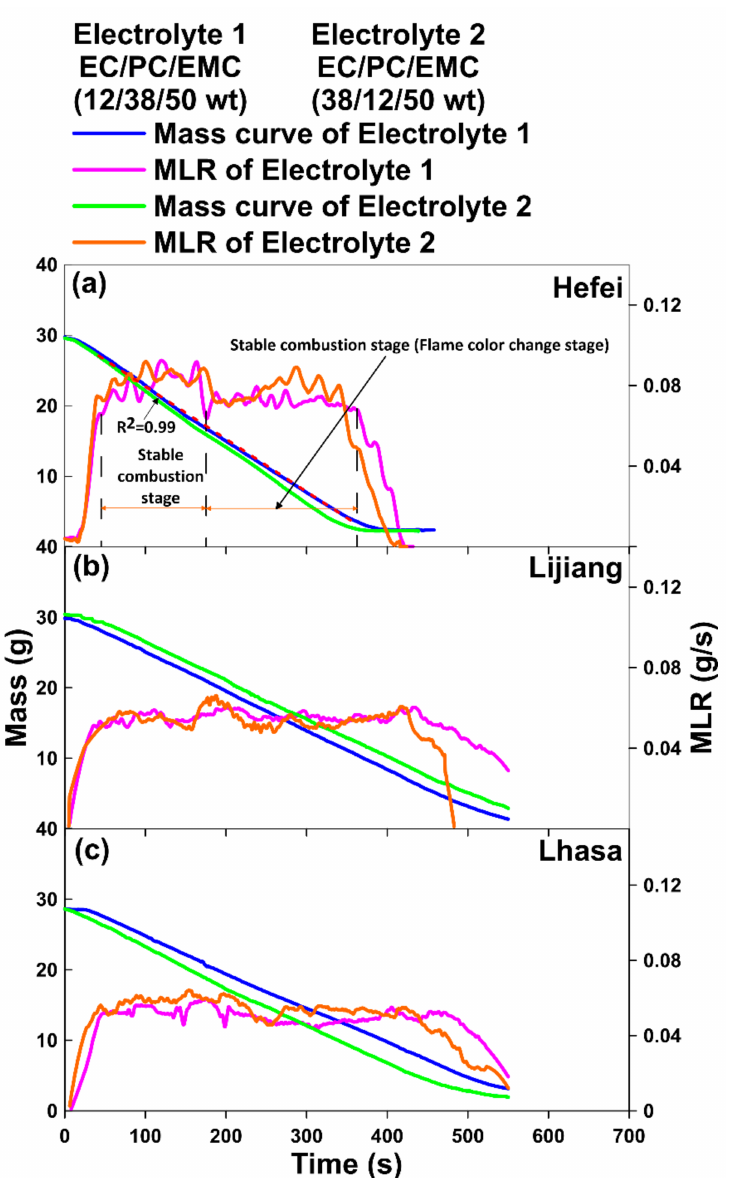
Figure 4. Mass change and MLR curves of two electrolytes in ( a ) Hefei (100.09 kPa), ( b ) Lijiang (76.11 kPa) and ( c ) Lhasa (65.23